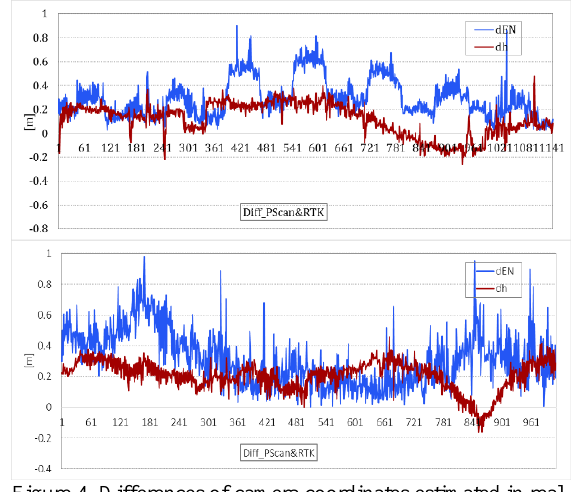
Figure 4. Differences of camera coordinates estimated in real- time processing (RTK) and in PhotoScan for Jokioinen (top) and Hyytiälä (bottom) area.